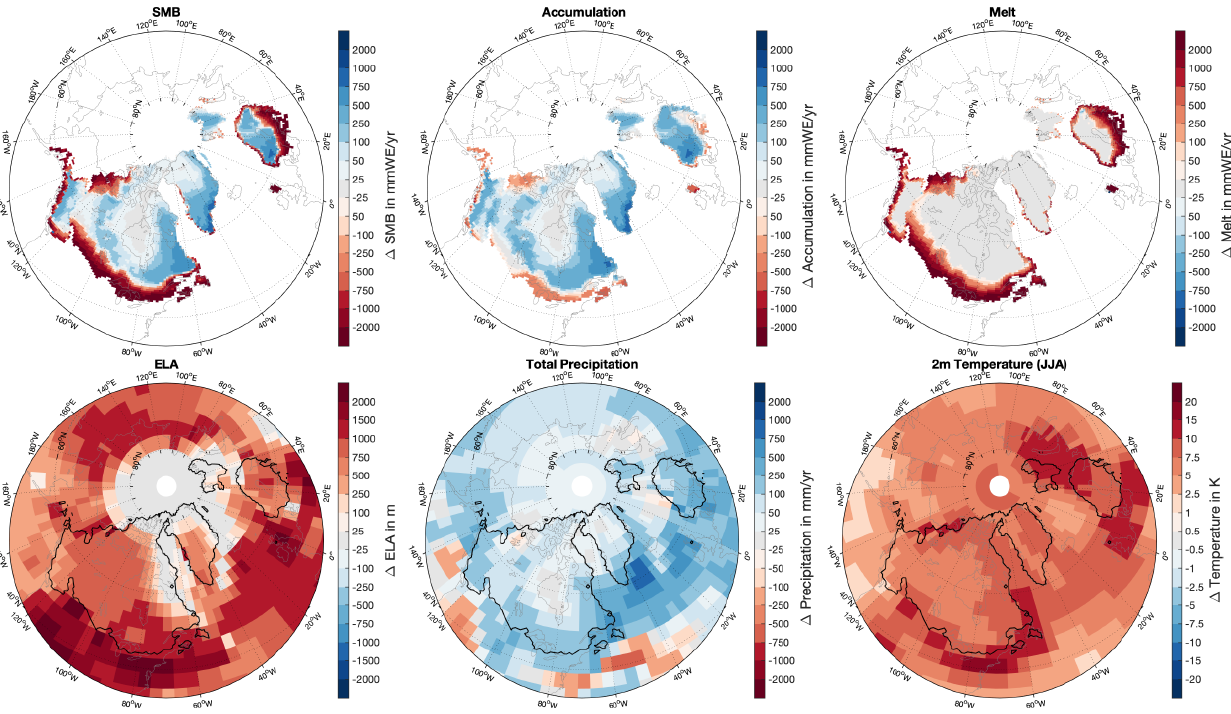
Figure 5. Differences in SMB, accumulation and melt, precipitation, and 2m temperatures, as well as 2m summer temperatures, between 15ka and the LGM. For the differences, SMB, accumulation, and melt are interpolated on the GLAC-1D topography of each individual time slice. The other variables are shown on the native MPI-ESM-CR model grid. Black contours in the lower panels indicate the ice-sheet mask at 15ka.